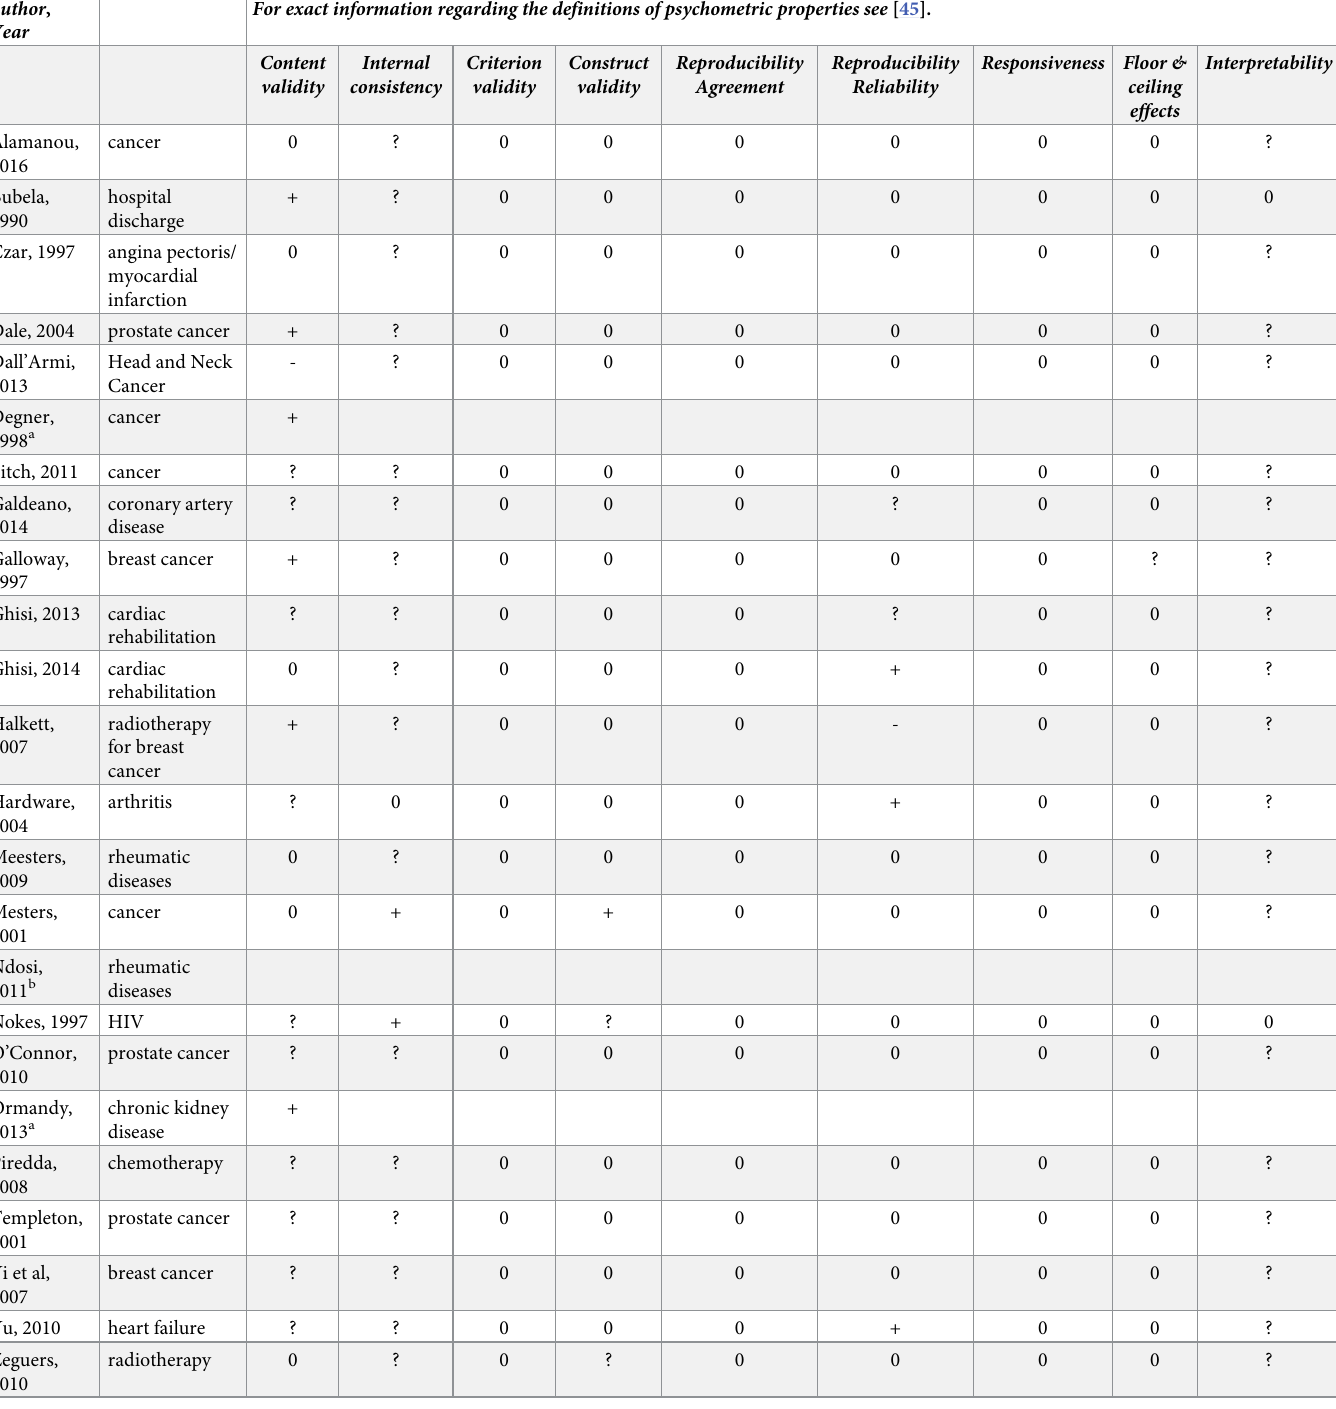
Table 6. Quality rating of psychometric properties with Terwee